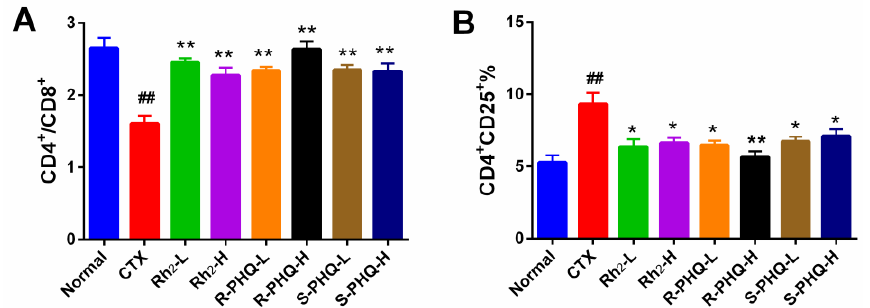
Figure 4. Effect of Rh 2 , R-PHQ, and S-PHQ on the ( A ) CD4+/CD8+; ( B ) CD4 + CD25 + %. The values are presented as mean ± SD, n = 10. ## p < 0.01 compared with the normal group. ** p < 0.01 and * p < 0.05 compared with the CTX group.